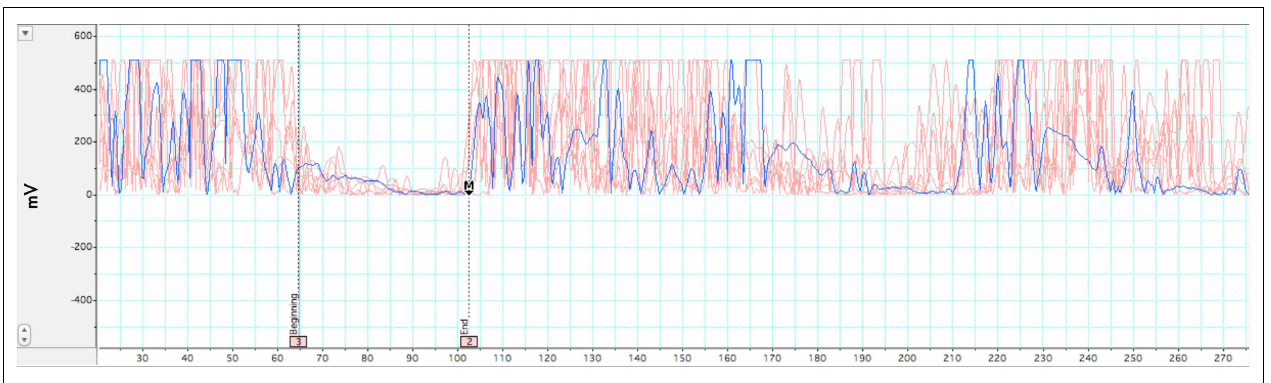
FIGURE 2 | Illustration of ipsilateral silent period . Rectified EMG across multiple trials within a single participant while holding isometric force at 35–50% MVC. In-graphic lines represent beginning and end of EMG